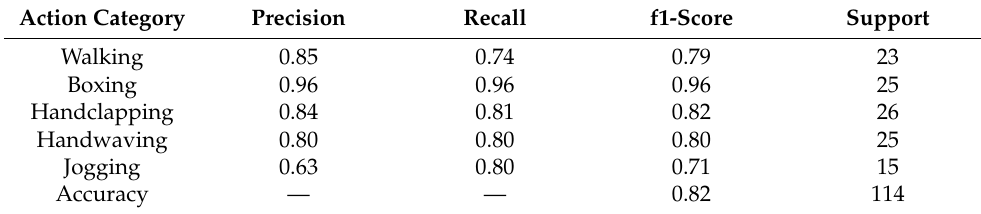
Table 1. Classification results for Raw using KNN-DTW for KTH-5.